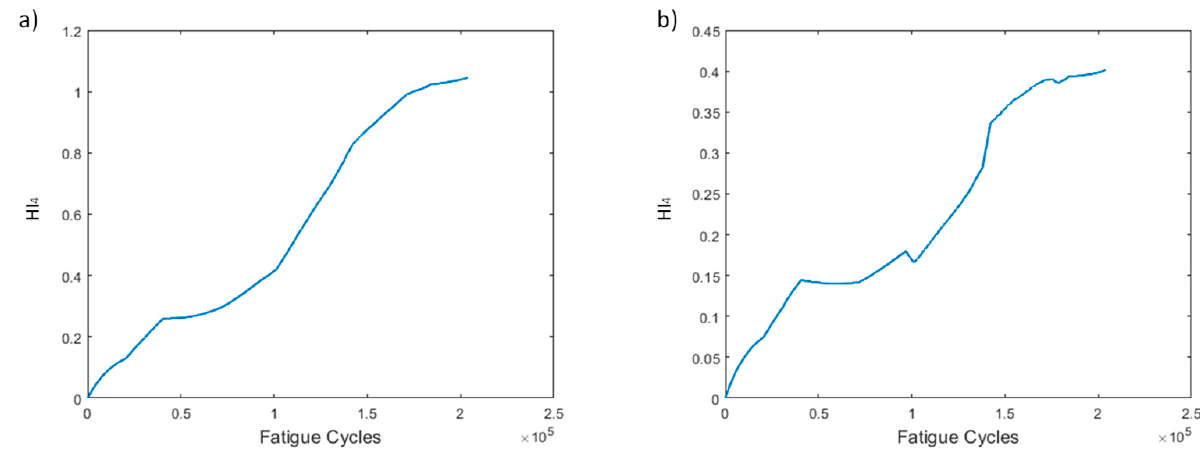
Figure 17. HI 4 progression through time for the two pre-processing methods for specimen VA-1: ( a ) method 1, ( b ) method 2.